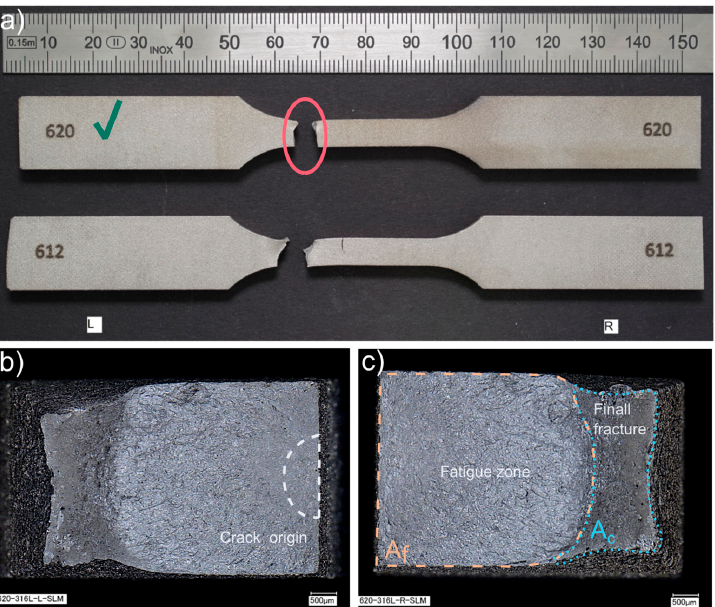
Figure 14. Fatigue fractures of Renishaw AM400 316L samples presented as: ( a ) fractured specimens during the fatigue tests; ( b ) fracture surface (SEM image), left side, specimen 620, at 1,492,546 cycles; ( c ) fracture surface (SEM image), right side, specimen 620, at 1,492,546 cycles. The samples have been numbered, which are visible in the figure. The letters L and R stand for the left-hand and right-hand sides of the sample in the figure. A green check mark means the specimen whose fracture faces were shown.